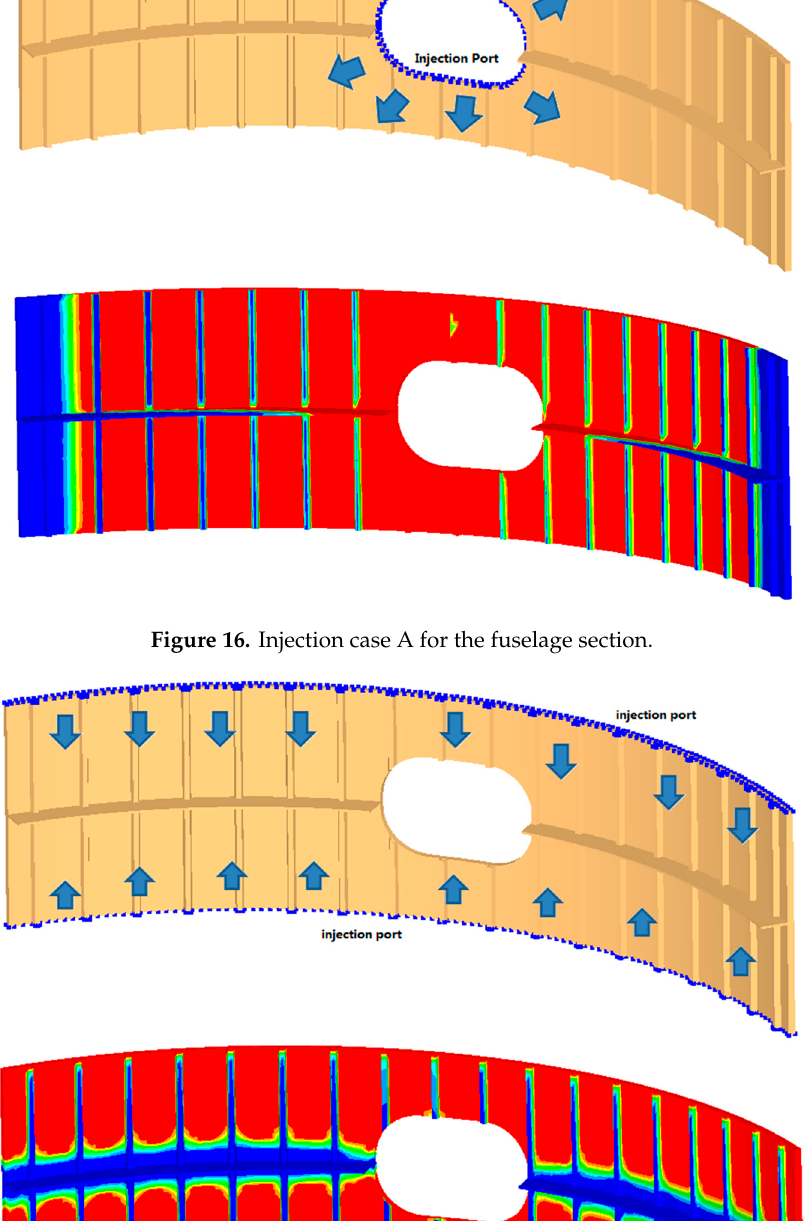
Figure 15. Details of the fuselage section geometry.